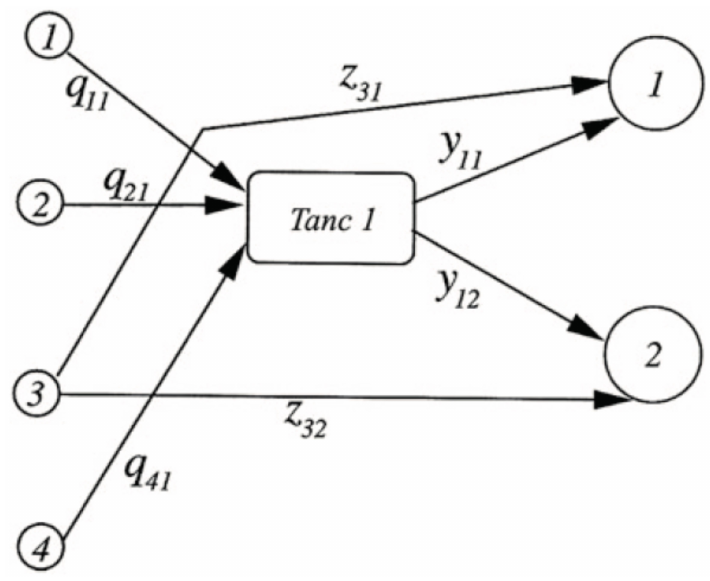
Figure 6. Structure representation of petrochemical pooling